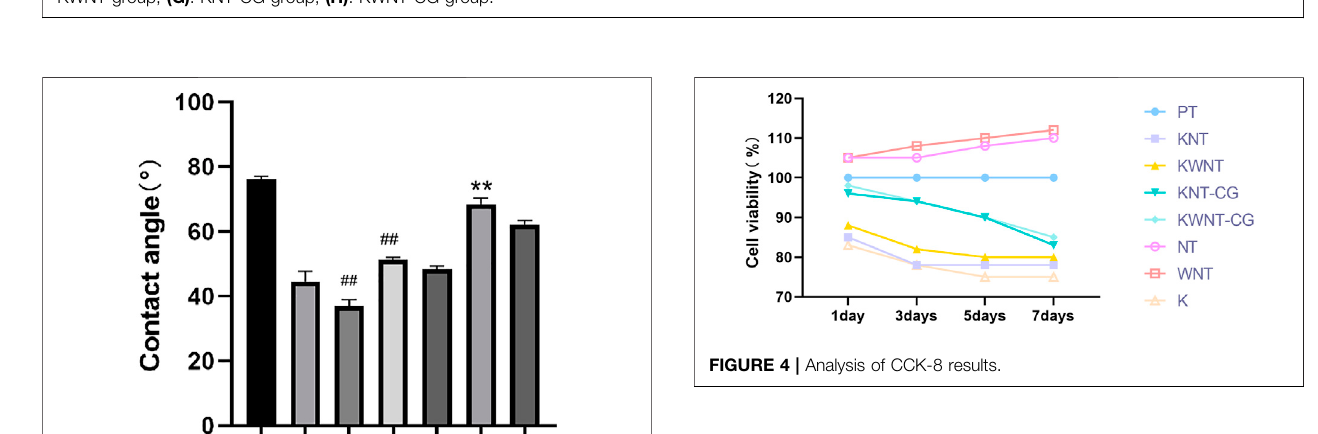
FIGURE 2 | Surface morphology of each titanium sheet under SEM. (A) : PT group; (B) : Micron structure; (C) : NT group; (D) : WNT group; (E) : KNT group; (F) : KWNT group; (G) : KNT-CG group; (H) : KWNT-CG group.